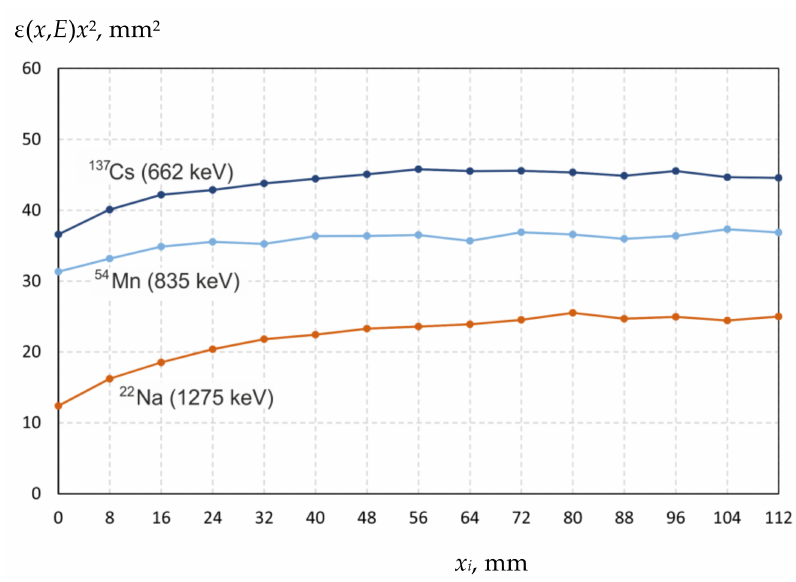
Figure 3. The dependence ε ( x , E ) x 2 for 137 Cs, 54 Mn, and 22 Na sources of photon